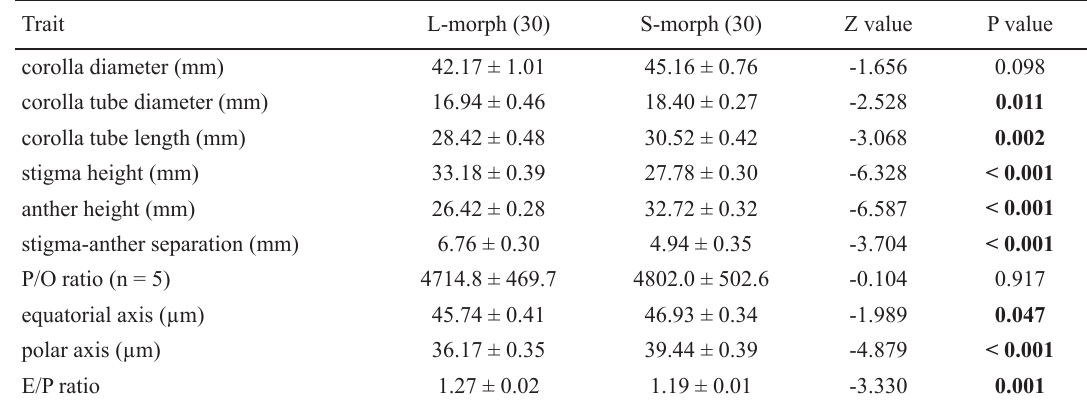
Table 1 – A comparison of floral traits and pollen traits between L-morph and S-morph flowers in Cordia subcordata (mean ± SE) by Mann-Whitney U test (0.05 level). Number of flowers per morph (long-styled and short-styled) is indicated between brackets. All data were obtained from the Yongxing Island population.